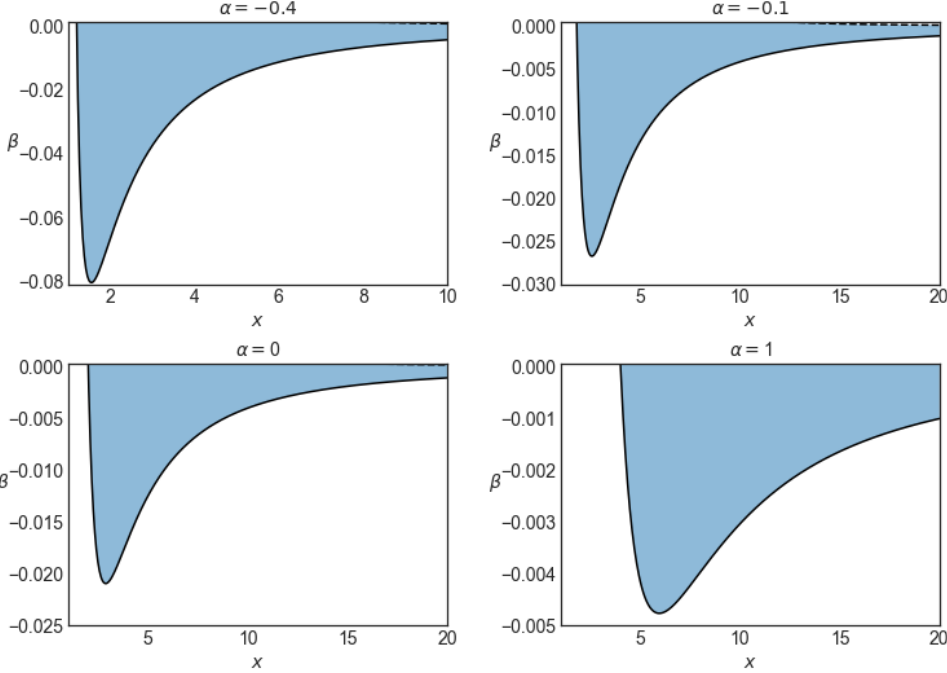
Figure 2. The domain of existence of circular orbits in the equatorial plane, ploted in the ( x , β )-plane. Lightlike orbits are located on the black curve, 2 S − x = 0. Timelike orbits’ positions form the blue area, which is bound by the locus of the null geodesics 2 S − x = 0 and the dashed curve S =